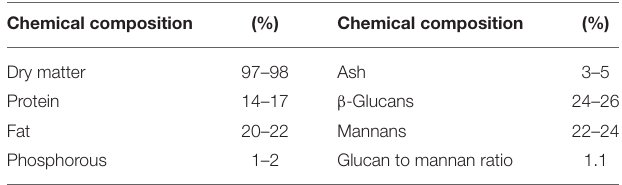
TABLE 1 | Chemical composition of the yeast cell wall fraction (YCW) according to manufacturer. Chemical